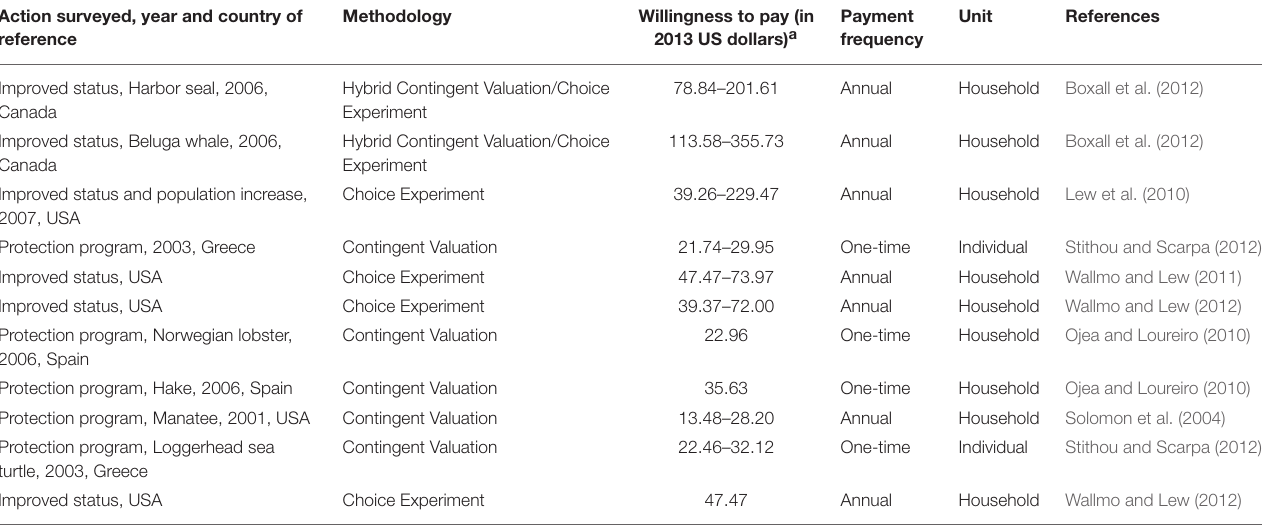
TABLE 7 | Summary of recent studies on agents’ willingness to pay for biodiversity and improved environmental